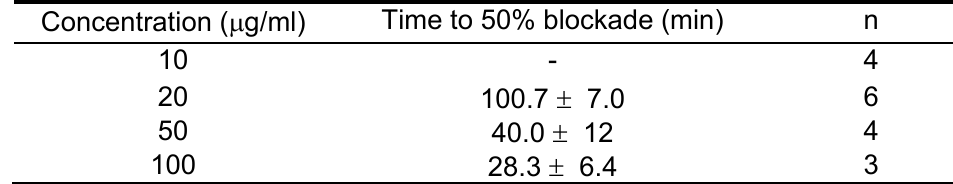
Table 1: Time to 50% blockade by B. n. pauloensis venom of twitches elicited by indirect stimulation in phrenic nerve-diaphragm preparations.